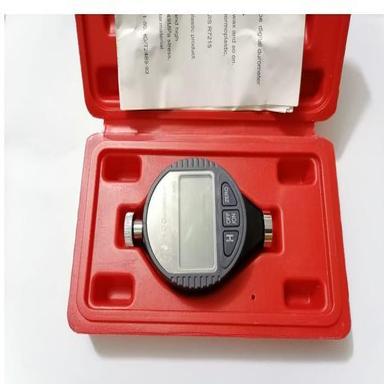
hardness devise.